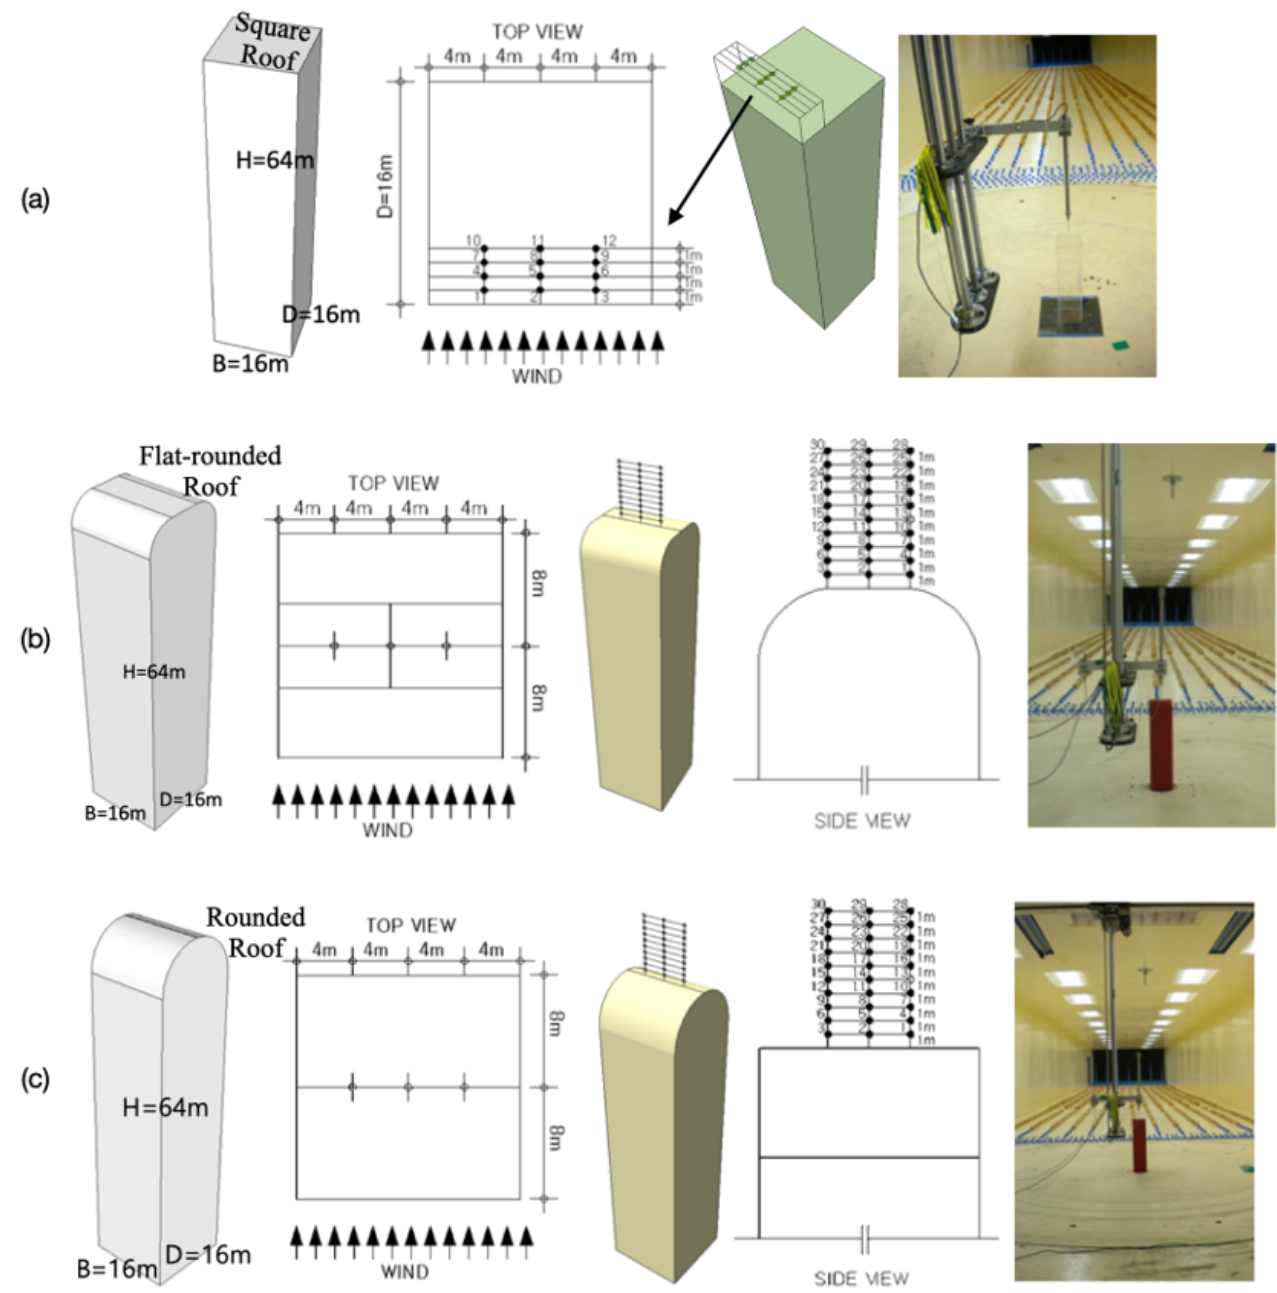
Figure 7. Wind turbine position at: ( a ) windward surface 5 on the top of the building; ( b ) windward surface 1 m up to 10 m on the top of the building; ( c ) windward surface 1 m up to 10 m on the top of building.